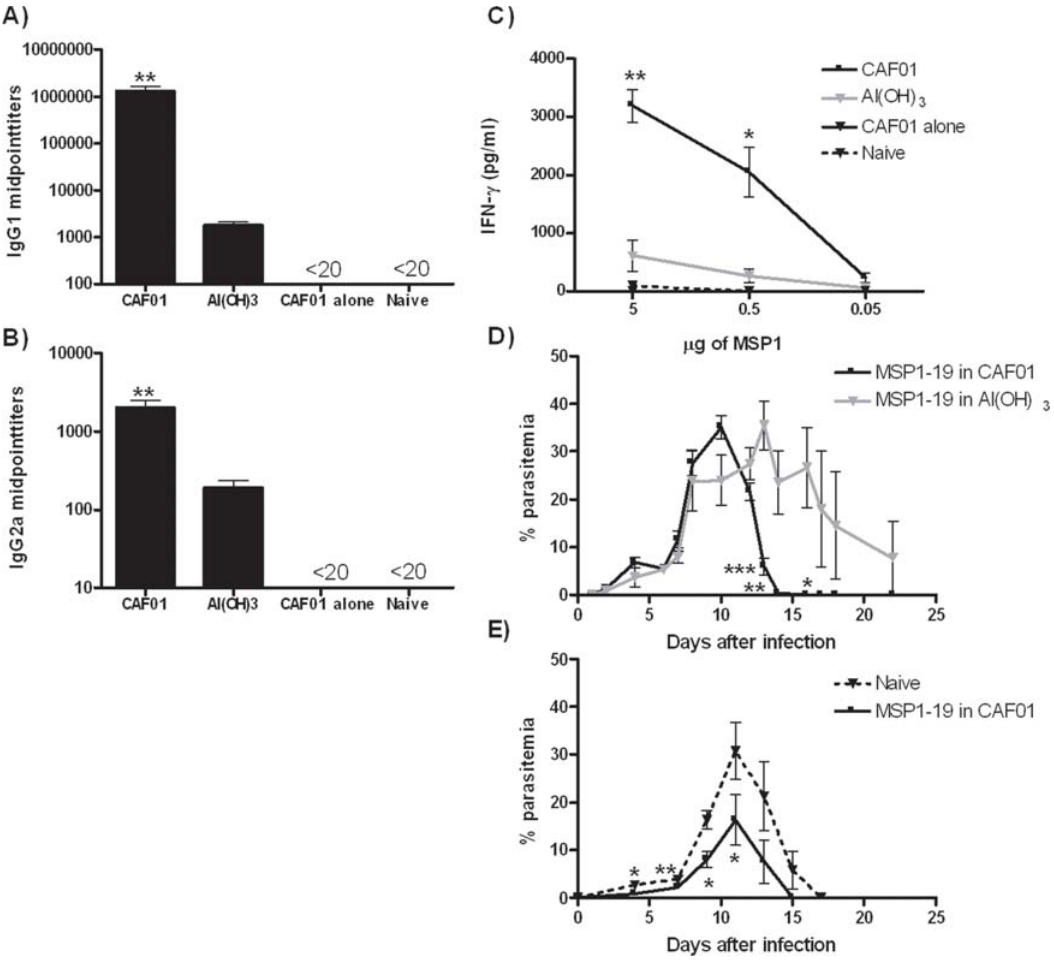
Figure 5. Immune responses and protection induced by CAF01 in a malaria blood-stage model. BALB/c mice were immunized three times with 10 m g of MSP1 in CAF01 or Al(OH) 3 . One week after the last immunization, mice were bled by periorbital puncture and individual sera tested for MSP1-specific A) IgG1 or B) IgG2a by ELISA (n=5). C) Individual cultures of splenocytes (n=3) were harvested at the same time point and re-stimulated in vitro with different concentrations of MSP1. The release of IFN- c was determined by ELISA. D and E) Three weeks after the last immunization, mice were challenged by the i.p. route with Plasmodium yoelli and the number of infected red blood cells measured at various time points during infection. Data shown are mean values of five mice 6 SEM. Values marked with an asterisk are significantly different (*, p , 0.05; **, p , 0.01, p , 0.001) compared to Al(OH) 3 -vaccinated as assessed by t-test.